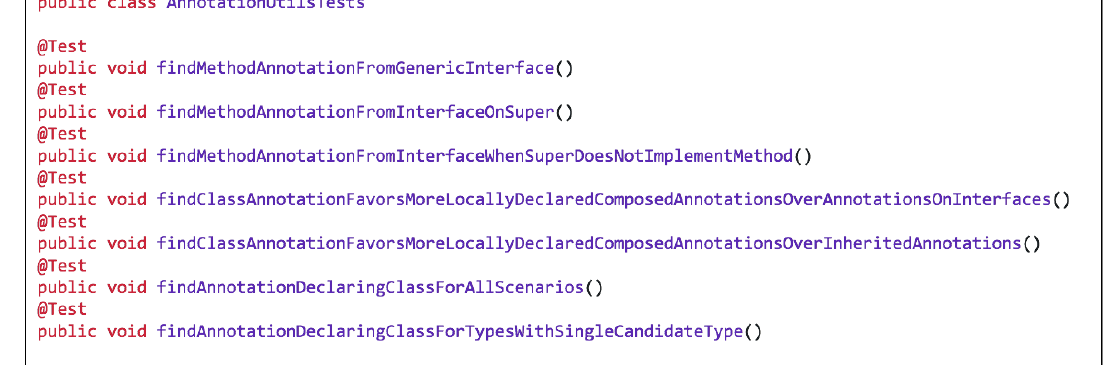
Figure 2. Examples of long, descriptive function names from the spring-framework